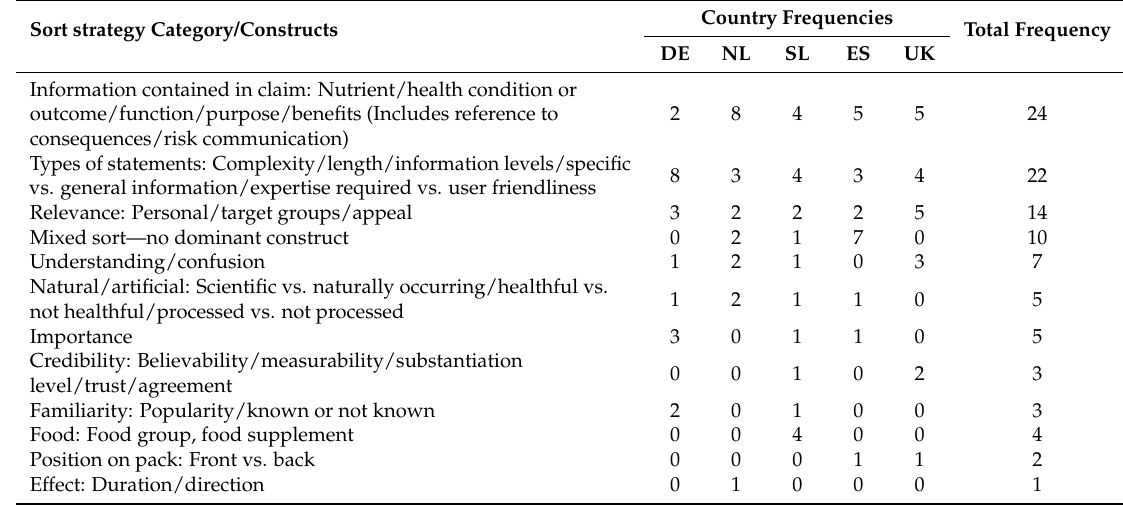
Table A2. Categories of constructs used in free sorting per